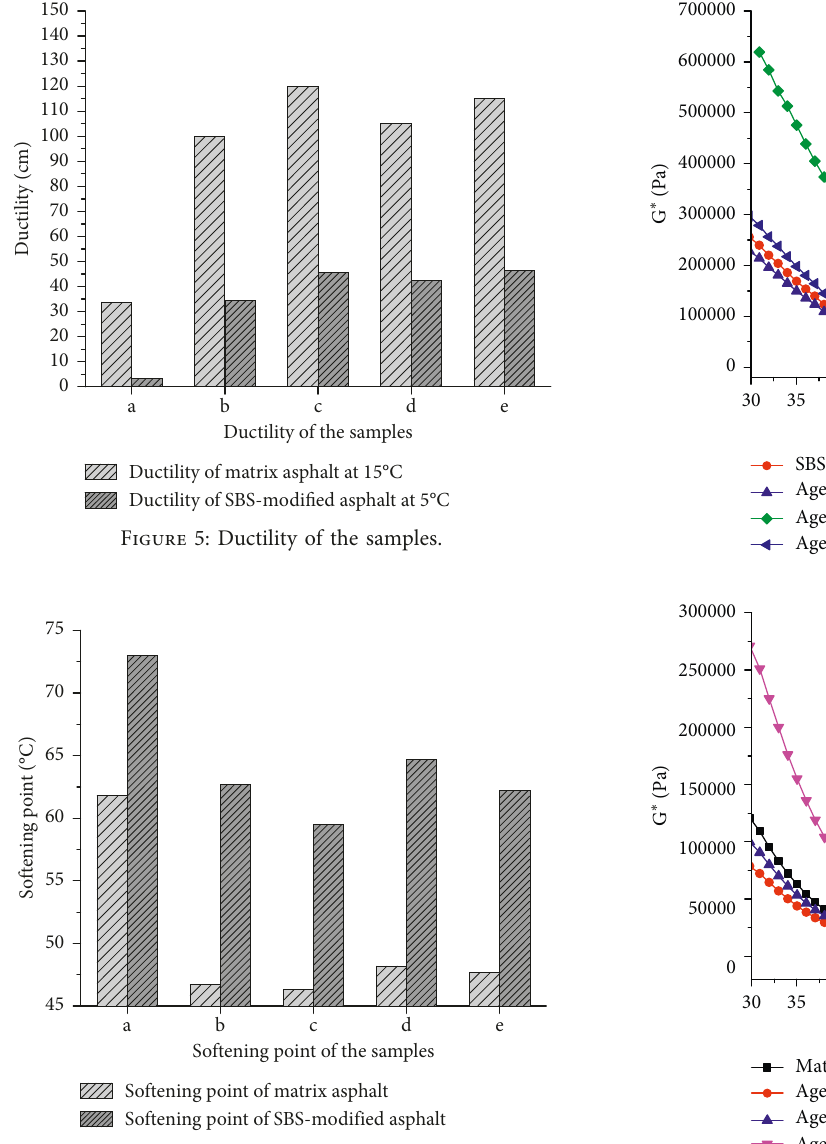
Figure 6: Softening point of the samples.